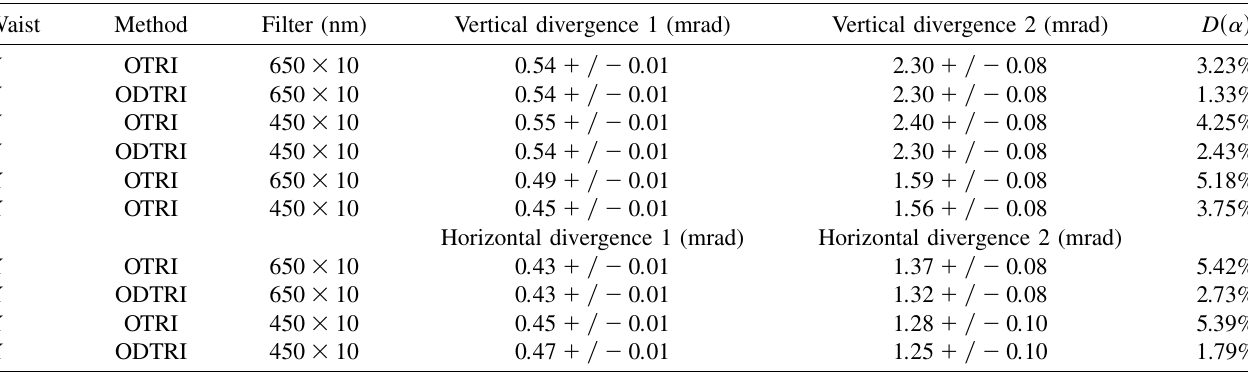
TABLE III. The rms divergences from double Gaussian fits to OTRI and ODTRI patterns obtained at vertical ( Y ) and horizontal ( X ) beam